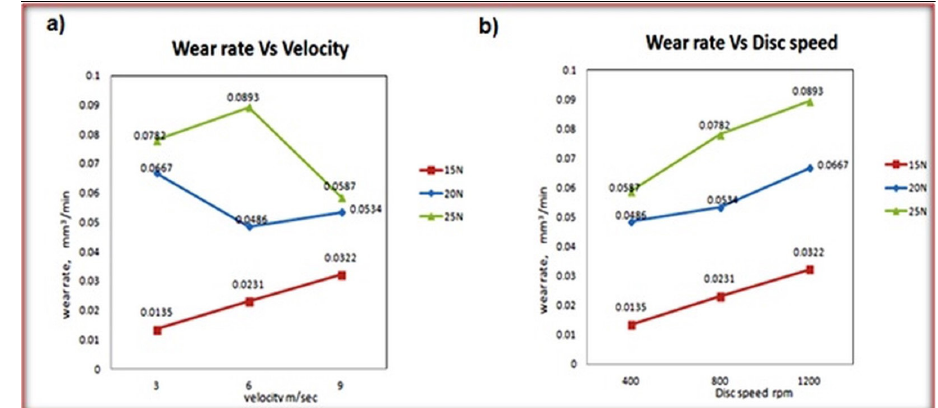
Figure 4. Wear rate of the samples a) function of velocity b) function of disc